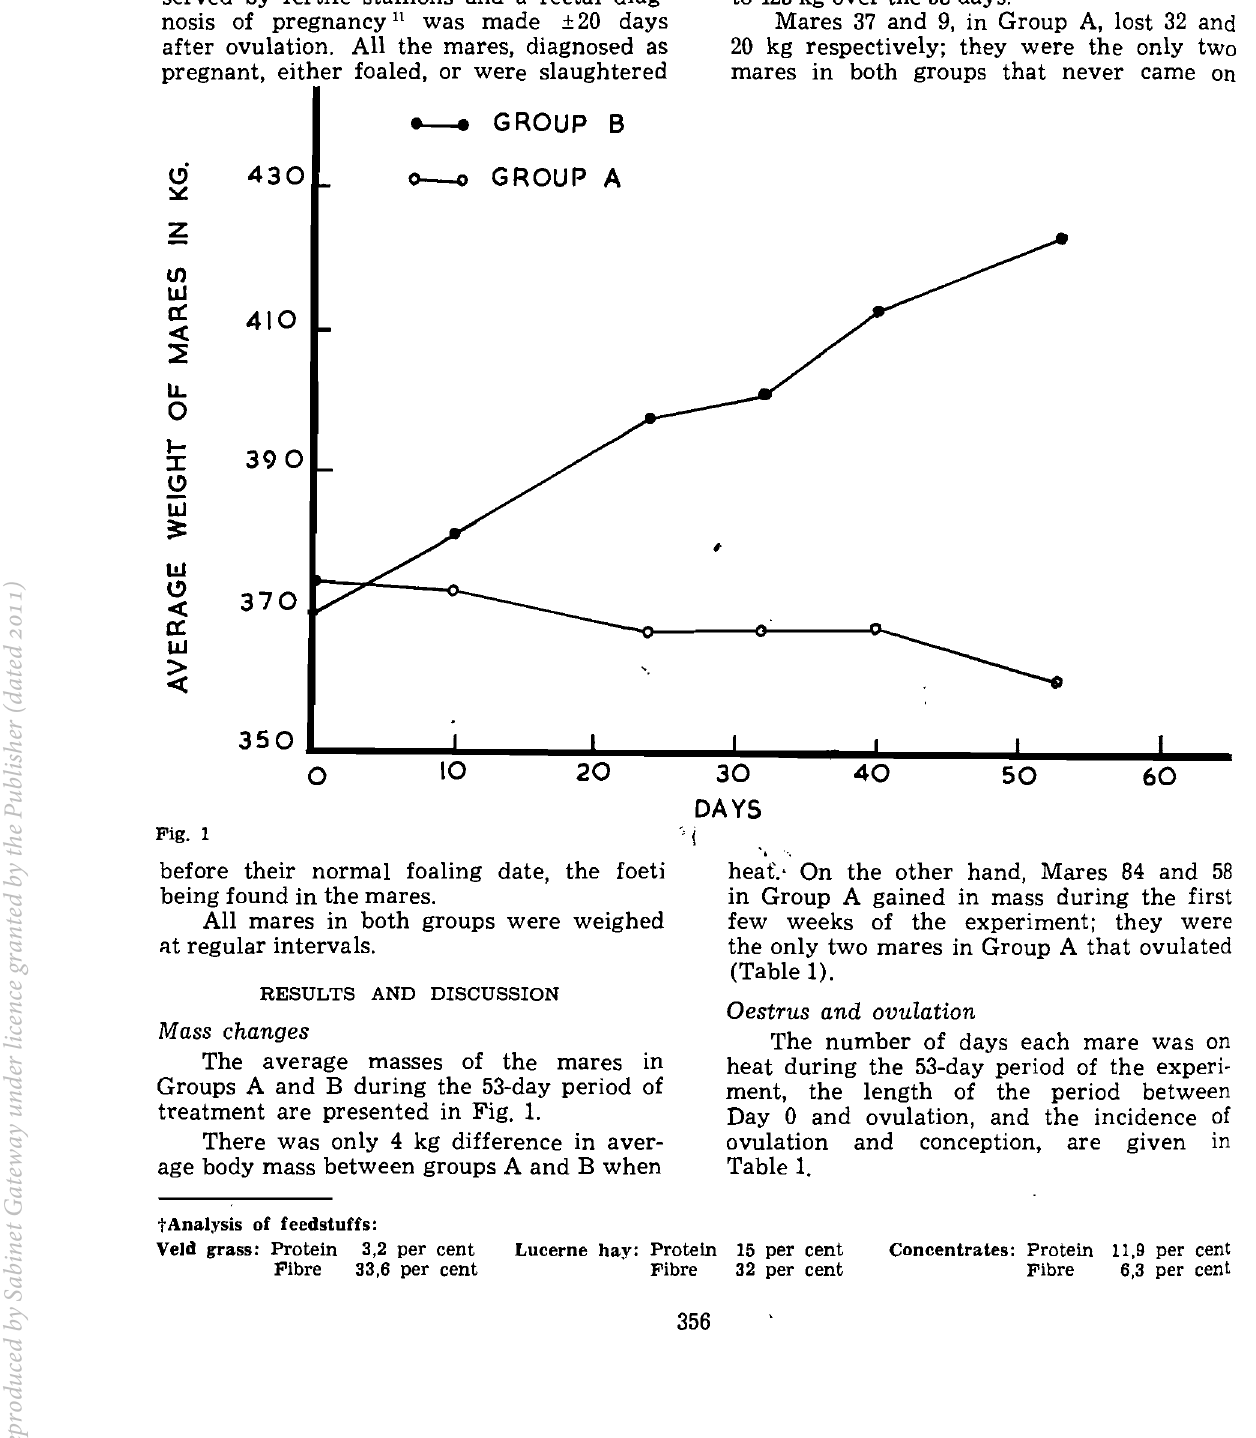
before their normal foaling date, the foeti being found in the mares. All mares in both groups were weighed ~t regular intervals.